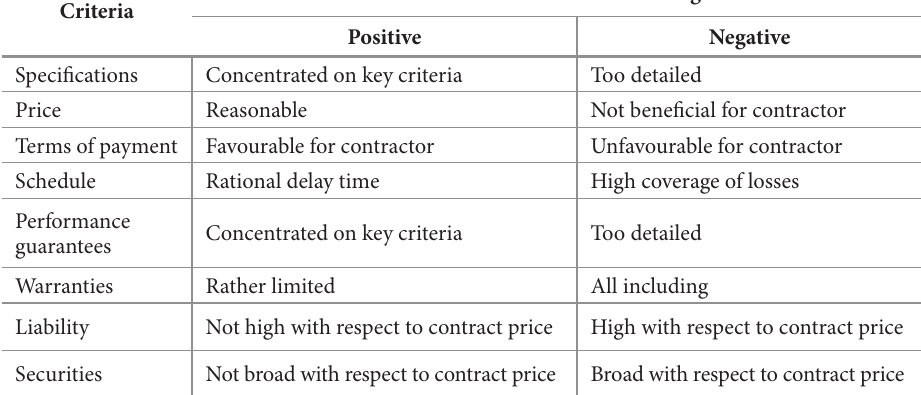
Table 2. Major contract provisions and their effect on contract